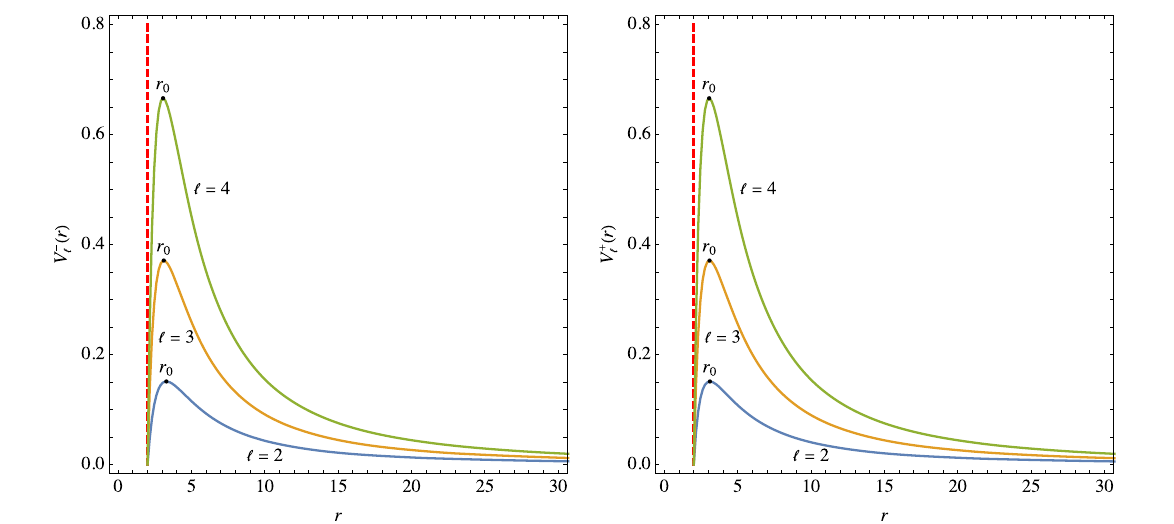
Fig. 5 The Regge–Wheeler effective potentials, plotted for α = 2 × 10 − 8 , γ = 2 × 10 − 20 / M , and the three cases of (cid:16) = 2 , 3 and 4. The red dashed line indicates the event horizon, and for each of the cases, the